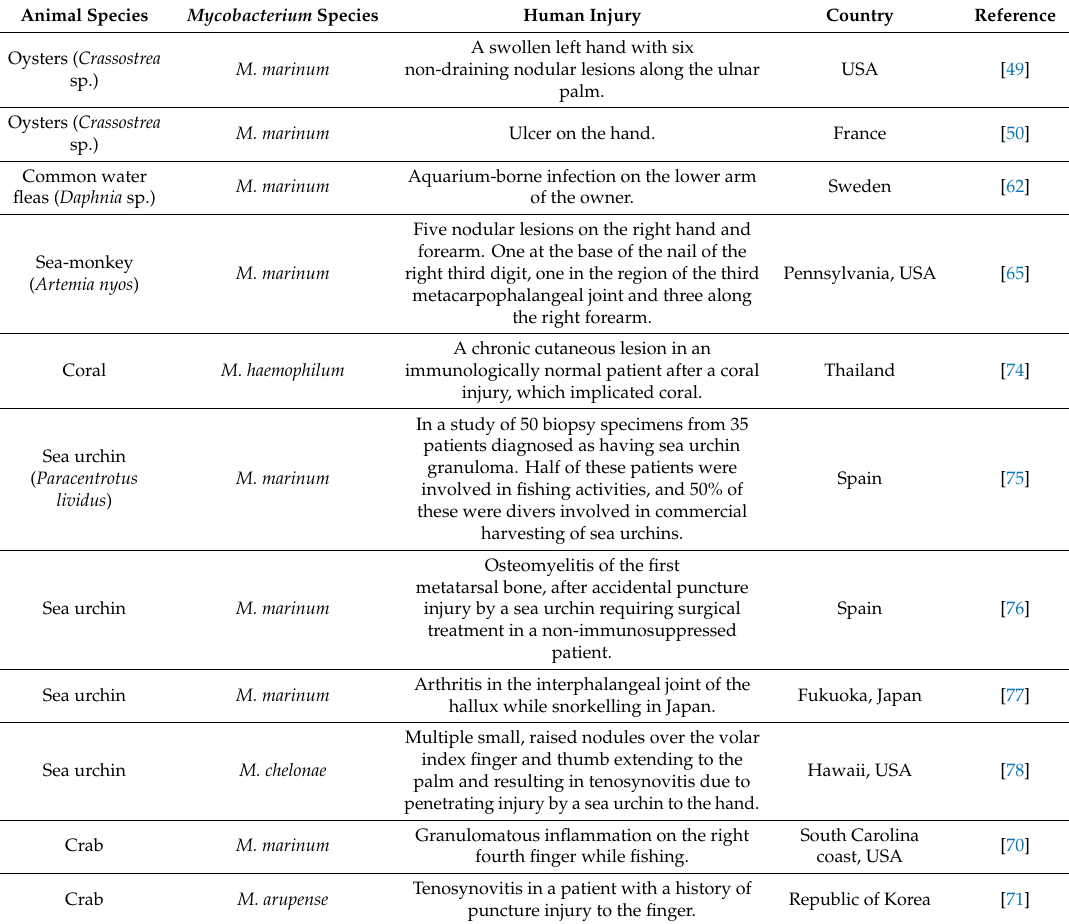
Table 4. Summary of human mycobacterioses related to aquatic invertebrates. Animal Species Oysters ( Crassostrea